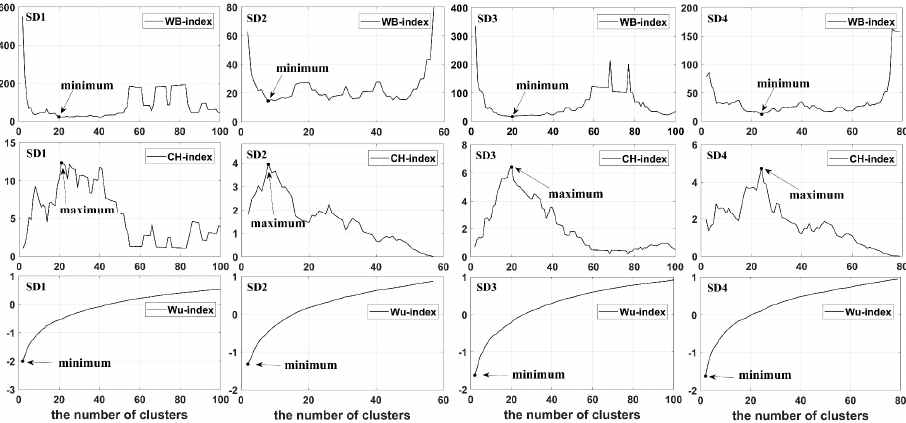
Figure 5. Relation graph for the number of clusters and three sum-of-squares based indices.